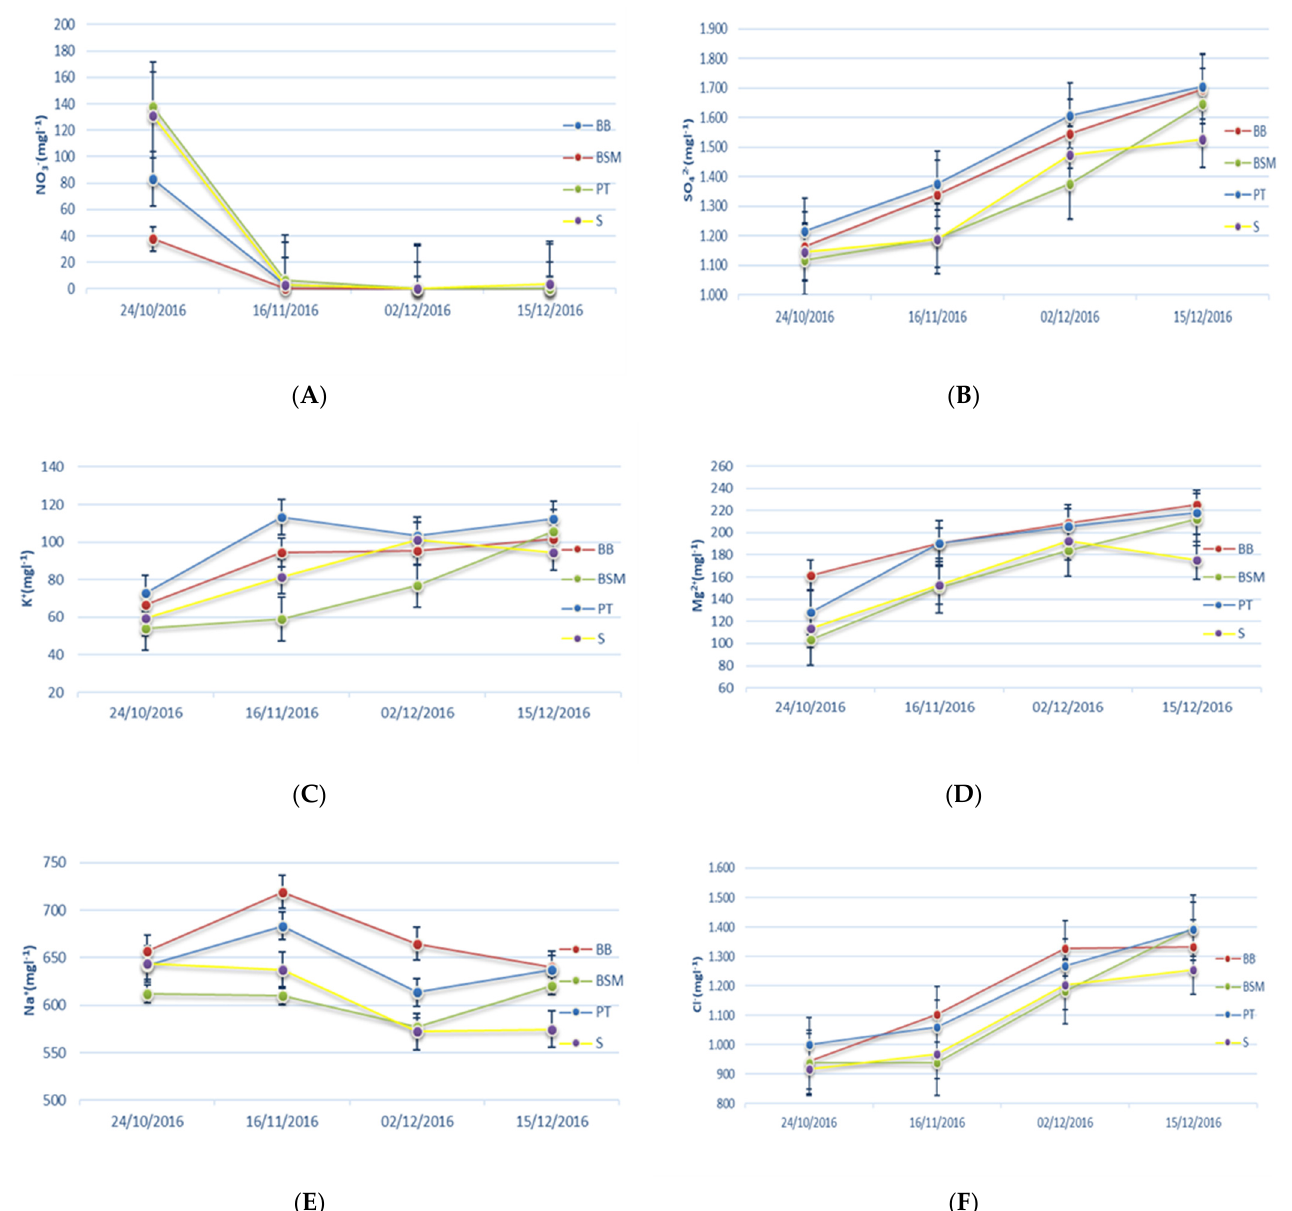
Figure 5. Composition of the soil solution during the lettuce growing cycle in the different treatments. ( A ). NO 3 − concentration. ( B ). SO 42 − concentration. ( C ). K + concentration. ( D ). Mg 2+ concentration. ( E ). Na + concentration. ( F ). Cl − concentration.